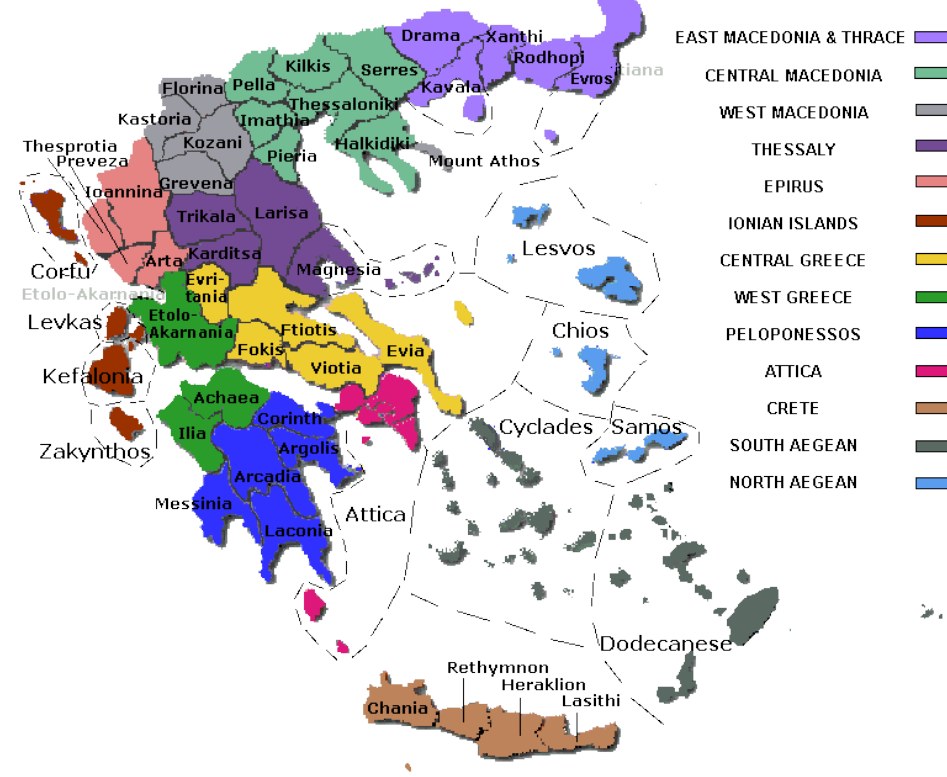
Figure 1. Place of research. Source: Own Elaboration.